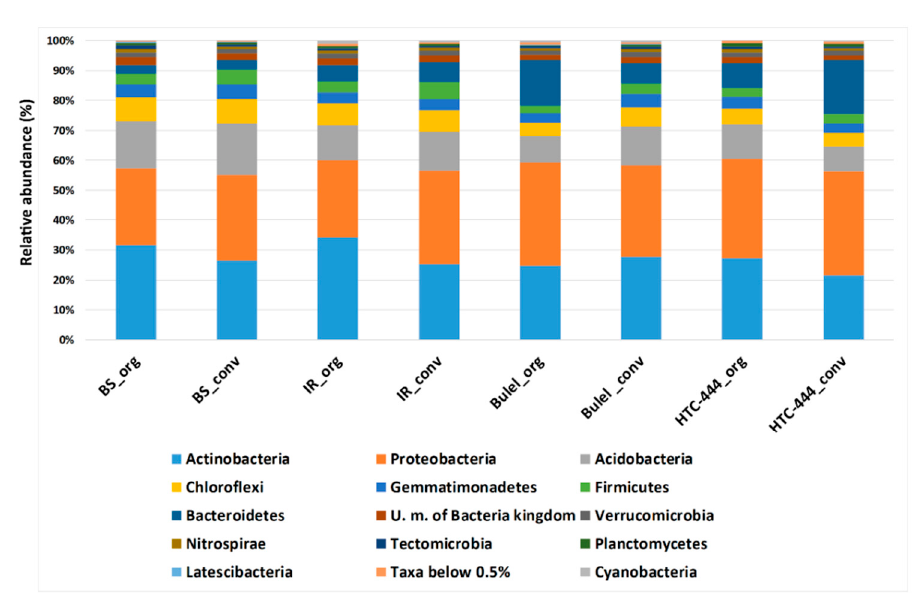
Figure 1. Microbial community composition at the phylum level in bulk soil (BS) and in the rhizosphere soil of durum wheat cv. Iride (IR), and Tritordeum cvs. Bulel and HTC-444 under organic (org) and conventional (conv) farming systems.